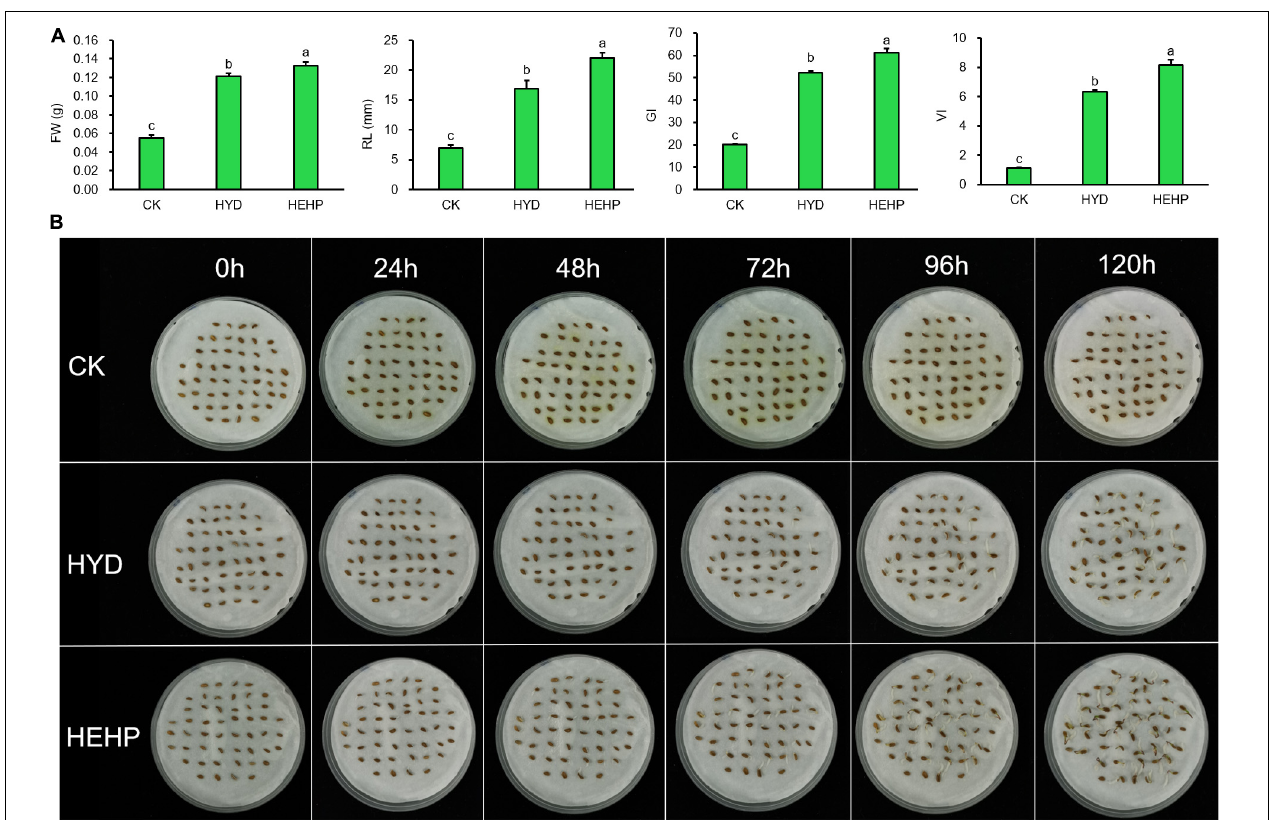
FIGURE 2 | Effects of different treatments on carrot seed germination. CK, the control; HYD, hydro-priming treatment; HEHP, hydro-electro hybrid priming treatment. (A) Effects of different treatments on carrot seed germination characteristics. (B) Photograph of seed germination experiment every 24 h. Values represent the means ± SE from six biological replications. The different lowercase letters above the bars indicate significant differences in 95% probability level ( p < 0.05, Duncan test was performed after ANOVA analysis).